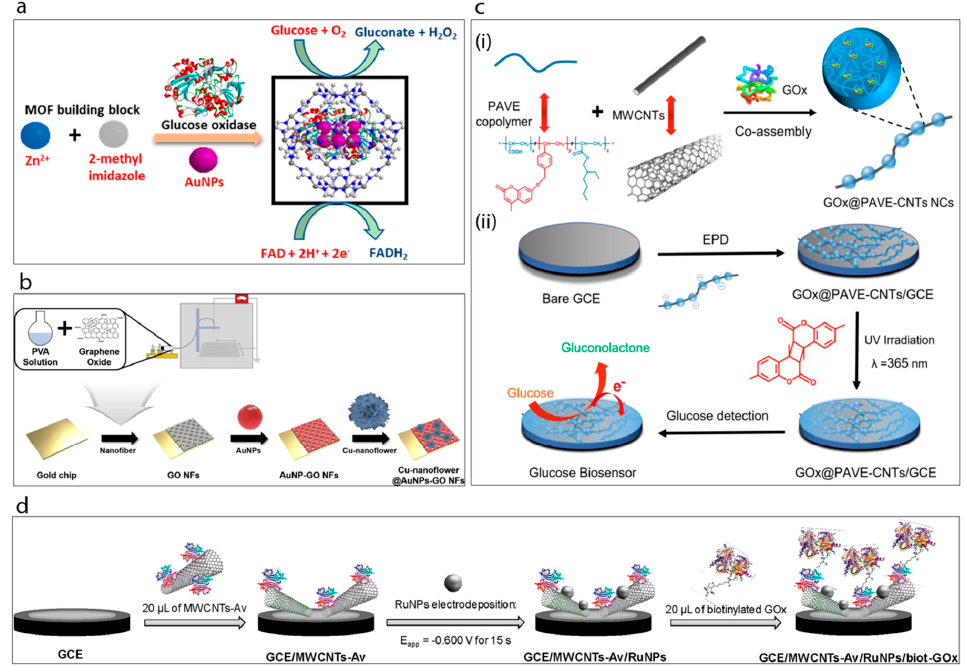
Figure 5. ( a ) Synthesis of GOx@ZIF-8(AuNPs) [53]. ( b ) Schematic display of the fabrication of Cu-